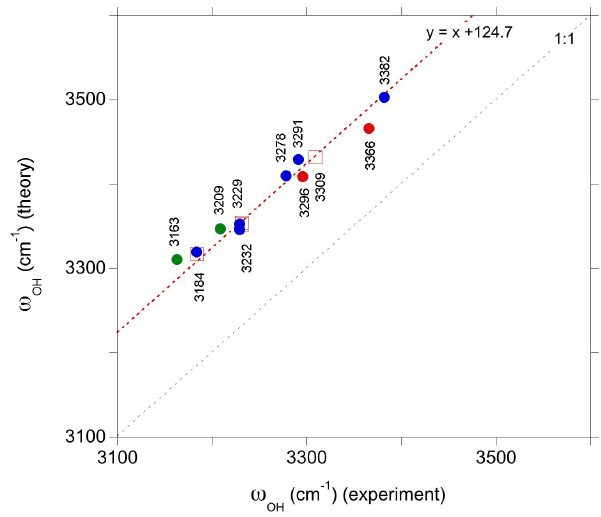
Figure 5. Comparison of theoretical and observed frequencies for the relevant defect models. The correlation has been determined us- ing the interpretation proposed for the three major bands observed in Ti-doped samples (open red squares). The other proposed in- terpretations correspond to the green, red and blue circles for the intrinsic and Ti- and V-bearing defects, respectively. Experimental frequencies are indicated on the